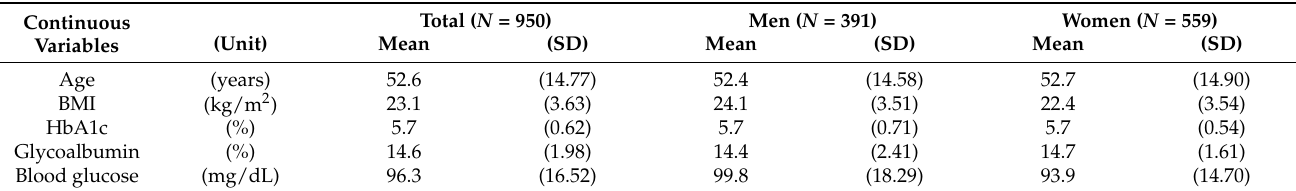
Table 1. Participant